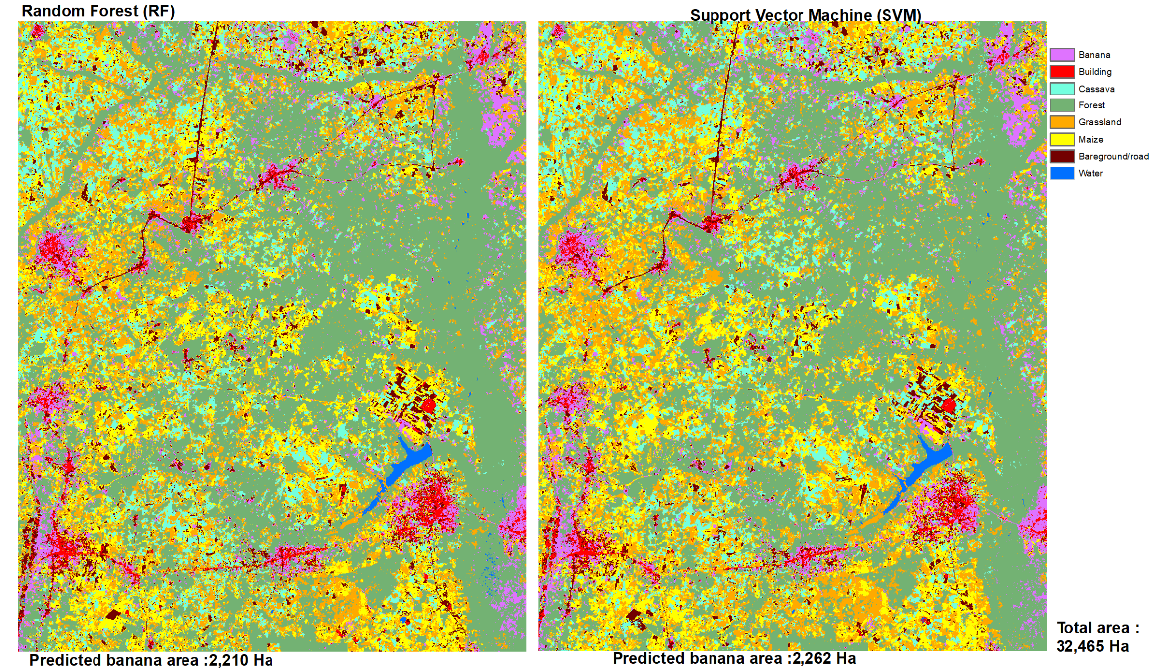
Figure 4. Prediction maps of the combination of the optical and SAR datasets by Radom Forest ( left ) and Support Vector Machine ( right ) models in the Idologun region, Ogun state in Nigeria.